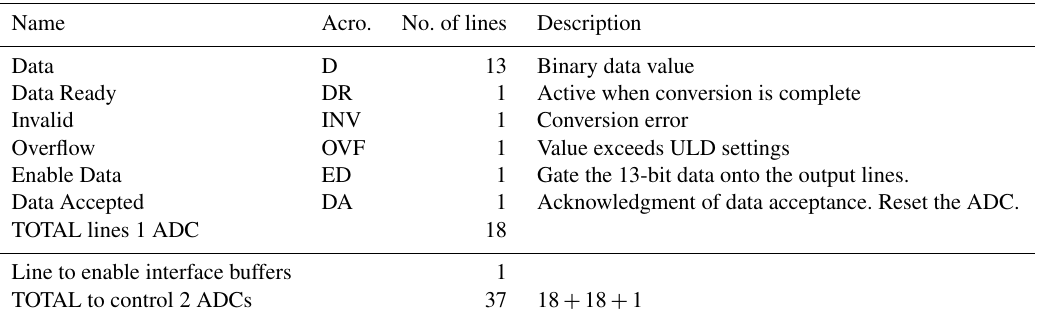
Table 2. GPIOs required by the processor card to control the ADC. We need 18 lines to read data and control one ADC. Another line is needed to enable and disable the interface buffers, which has been added to protect the processor card.